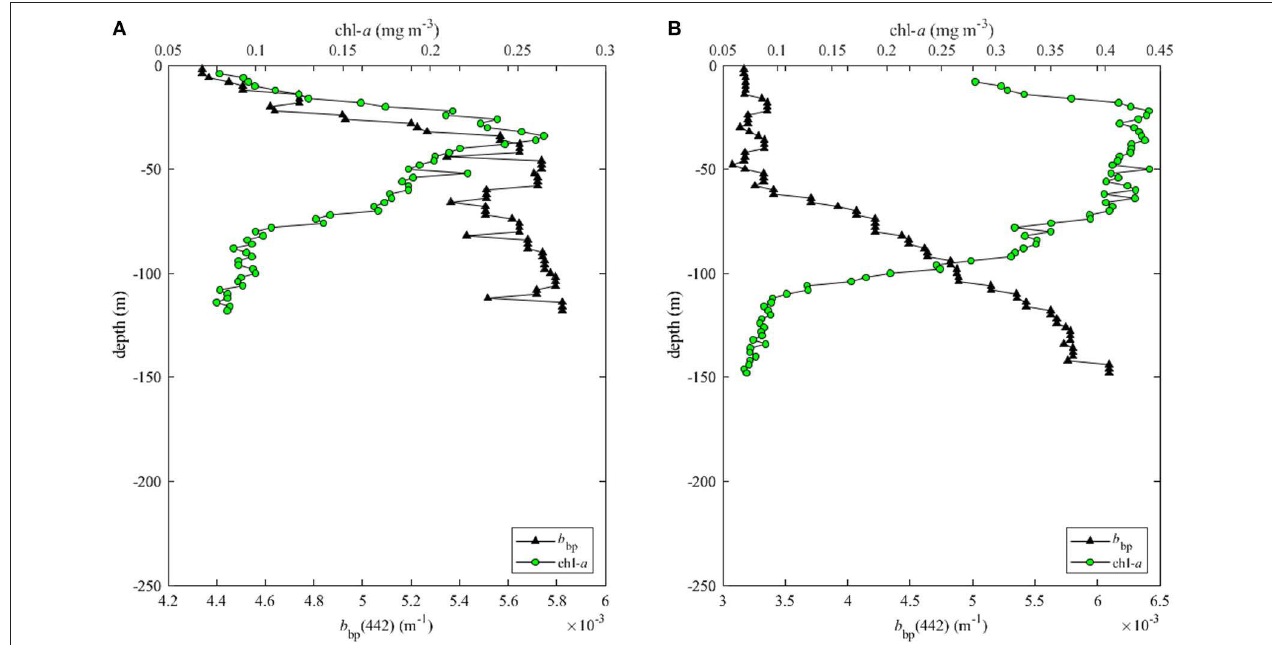
FIGURE 6 | Vertical profiles of chlorophyll concentration (chl- a ) and particulate backscattering at 442nm [ b bp (442)] at (A) M66 station located close to McDonald Island and (B) T2 station located close to Heard at the beginning of Transect C.